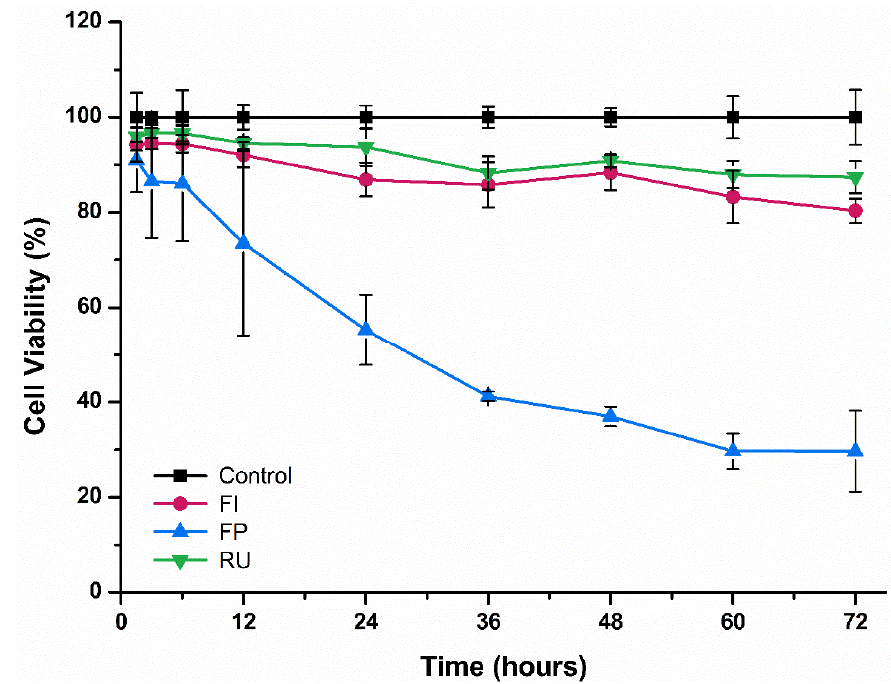
Figure 1. Cell viability of immortalized human oral keratinocytes (IHOK) following exposure to Fuji I (FI), Fuji Plus (FP) and Rely X U200 (RU) for varying duration of time.